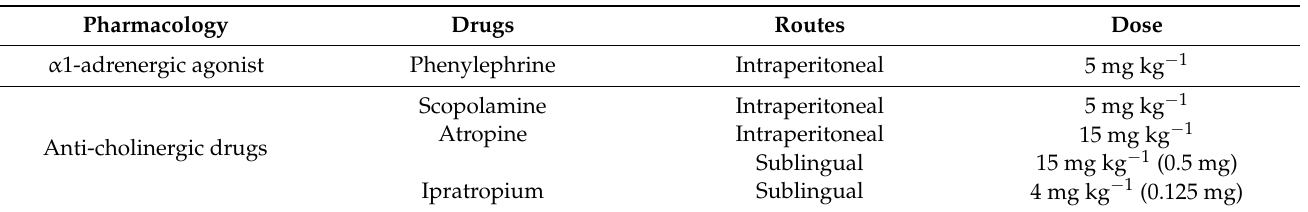
Table 1. Pharmacological class, molecules, routes, and doses evaluated for the drug screening. Atropine and Ipratropium were sublingually administrated at a fixed